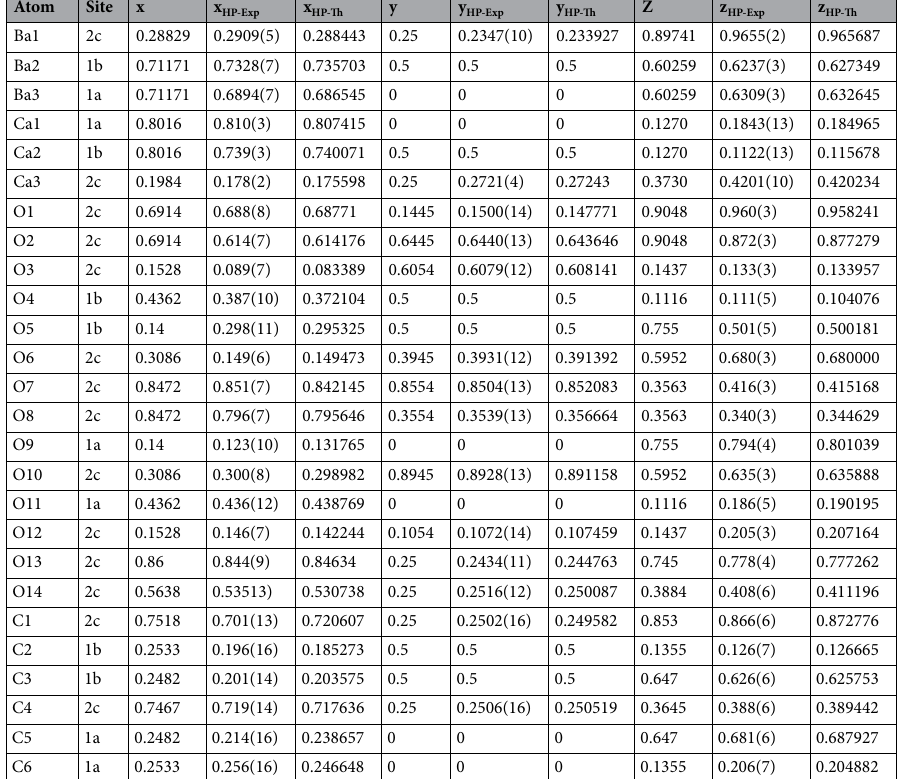
Table 2. Experimental atomic coordinates (x, y, z) of the initial barytocalcite structure at ambient conditions described with the Pm space group (once the symmetry reduction, cell doubling and origin shift mentioned in the main text are applied; a = 6.5503(2) Å, b = 10.4868(4) Å, c = 8.1091(3) Å, β = 106.019(4)º) to be compared with those of the high-pressure Pm experimental post-barytocalcite phase at 9 GPa ( a’ = 6.4510(10) Å, b’ = 10.2907(7) Å, c’ = 7.775(3) Å, and β’ = 110.54(10)º) denoted as (x HP-Exp , y HP-Exp , z HP-Exp ) and the theoretically- calculated post-barytocalcite phase at 9.47 GPa ( a’ = 6.4168 Å, b’ = 10.232 Å, c’ = 7.6427 Å, and β’ = 111.53º) denoted as (x HP-Th , y HP-Th , z HP-Th